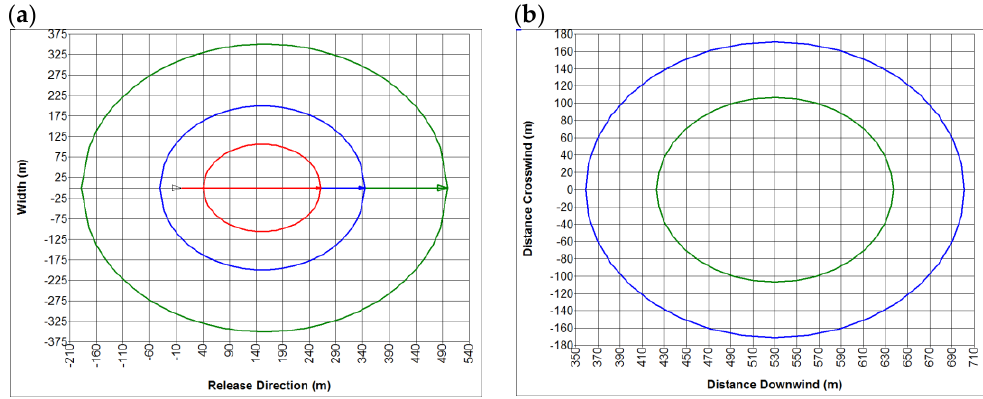
Figure 18. Hazard zones due to a jet fire ( a ) and an explosion ( b ) for a natural gas pipeline (a = 1)